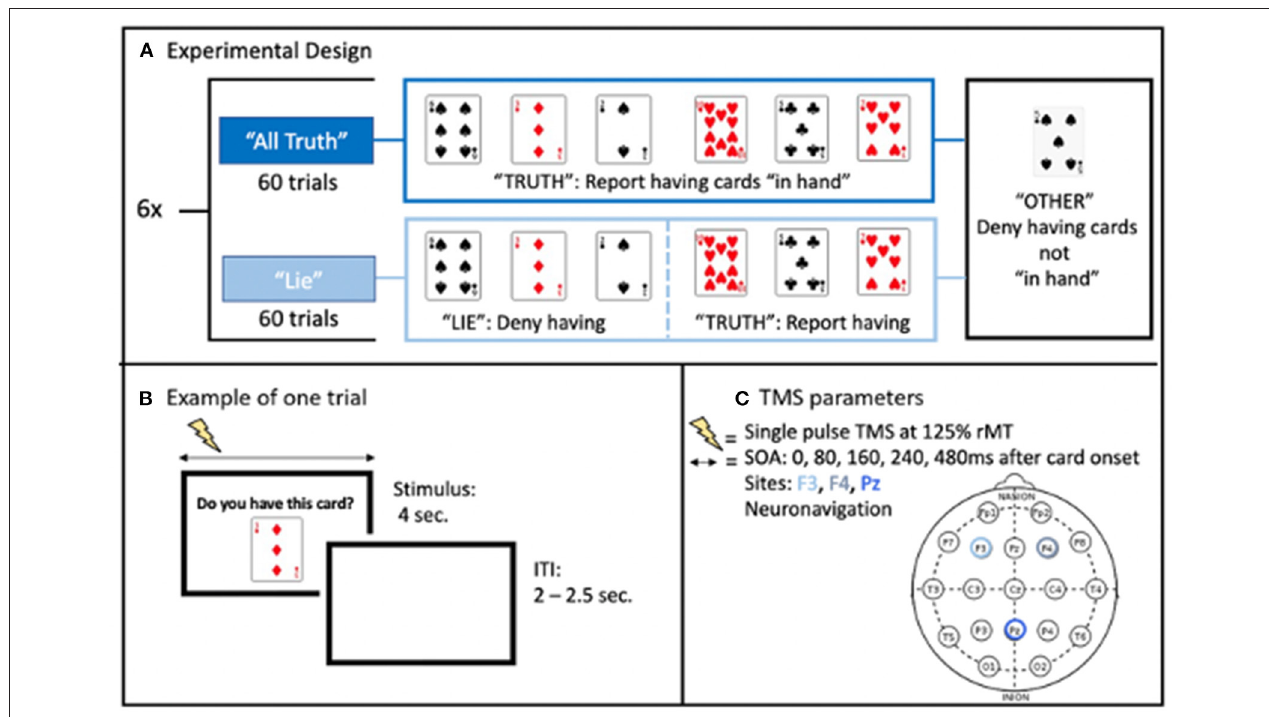
FIGURE 1 | (A) Illustration of the experimental design. (B) Example of one trial with each card presented for 4s, during which single pulse TMS was applied, and separated from each other by a random inter-trial interval. (C) Stimulation parameters with randomized stimulus onset asynchrony (SOA) relative to the card presentation